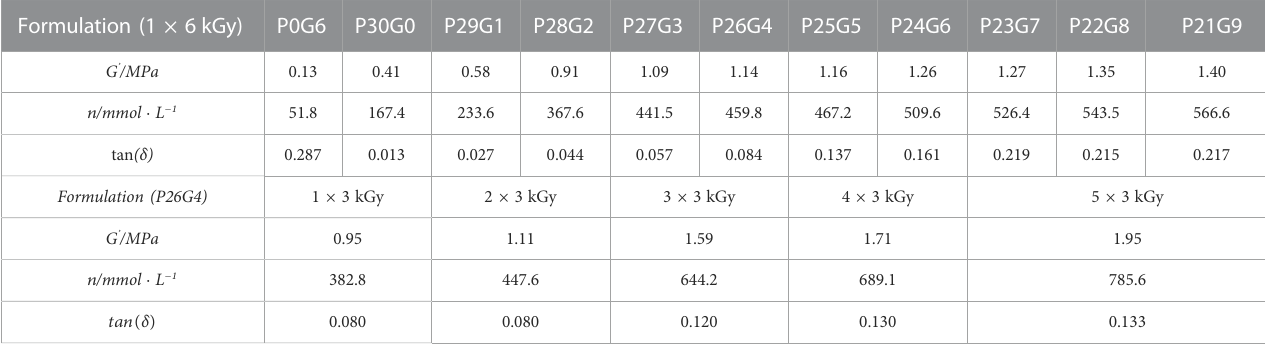
TABLE 2 Crosslinking density values calculated from the dynamic